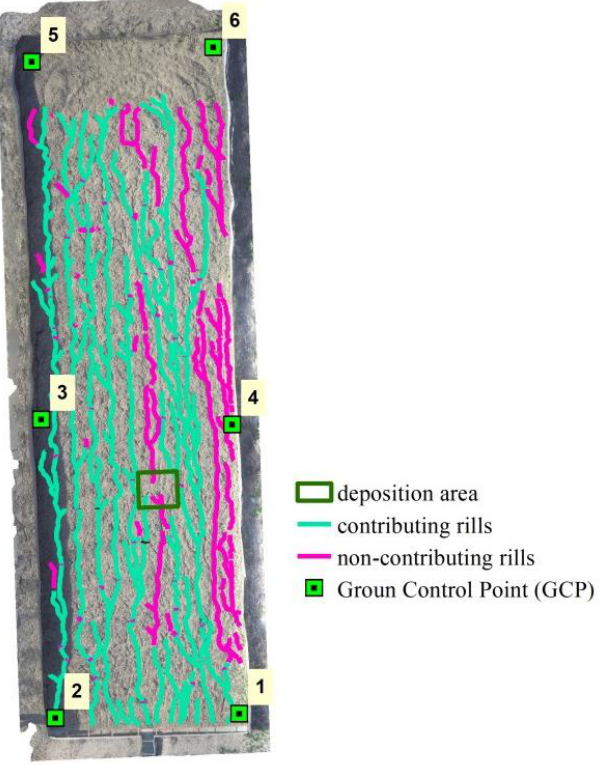
Figure 13. View of the P3 plot (22 m × 6 m, s = 26%) with Ground Control Points (GCPs) numbered from 1 to 6, contributing rills, non-contributing rills, and example of sediment deposition area (modified from [67]).